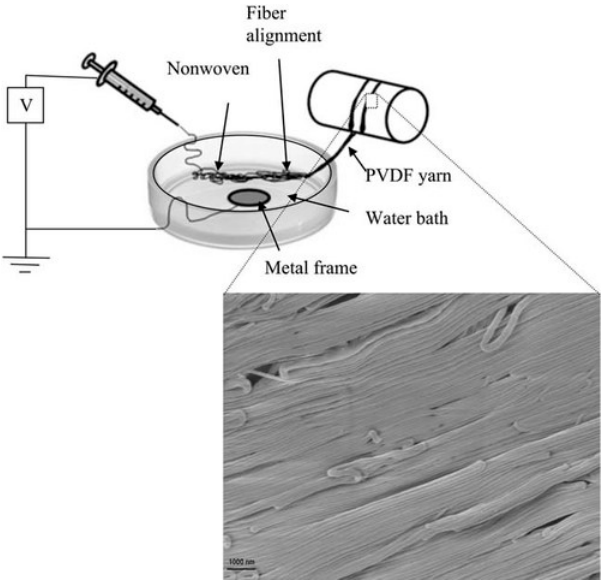
Figure 1. Modified electrospinning setup used to collect linear nanofiber assemblies. Reprinted from Macromolecular Materials and Engineering , Vol. 297, Avinash Baji, Yiu-Wing Mai, Xusheng Du, Shing-Chung Wong, Improved tensile strength and ferroelectric phase content of self-assembled polyvinylidene fluoride fiber yarns, 209–213, Copyright (2012), with permission from John Wiley and Sons.